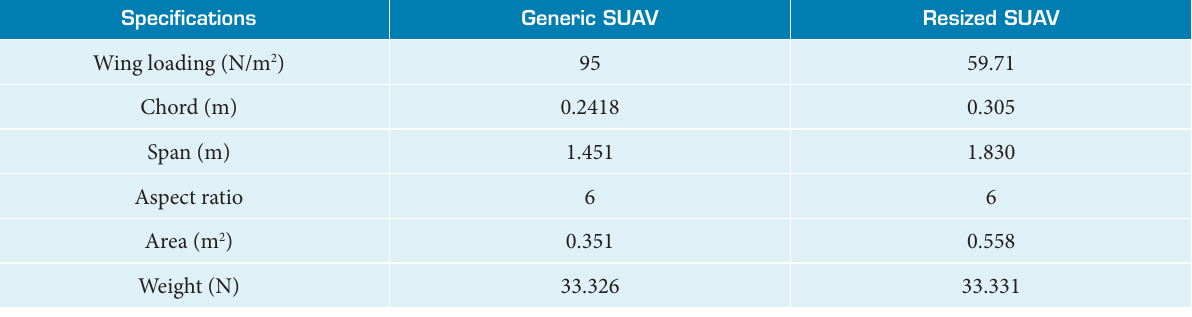
Table 9. Design data for resized